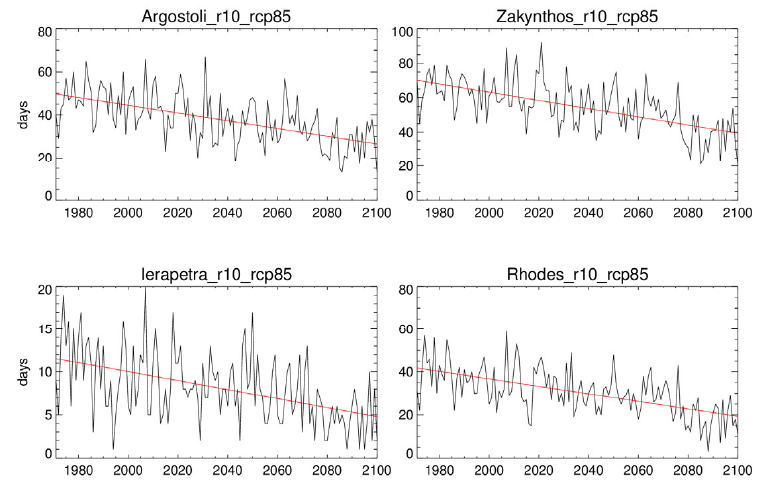
Figure 9. Annual number of days with precipitation not less than 10 mm (R10mm) during 1971–2100 in four Greek stations, based on RCP8.5.